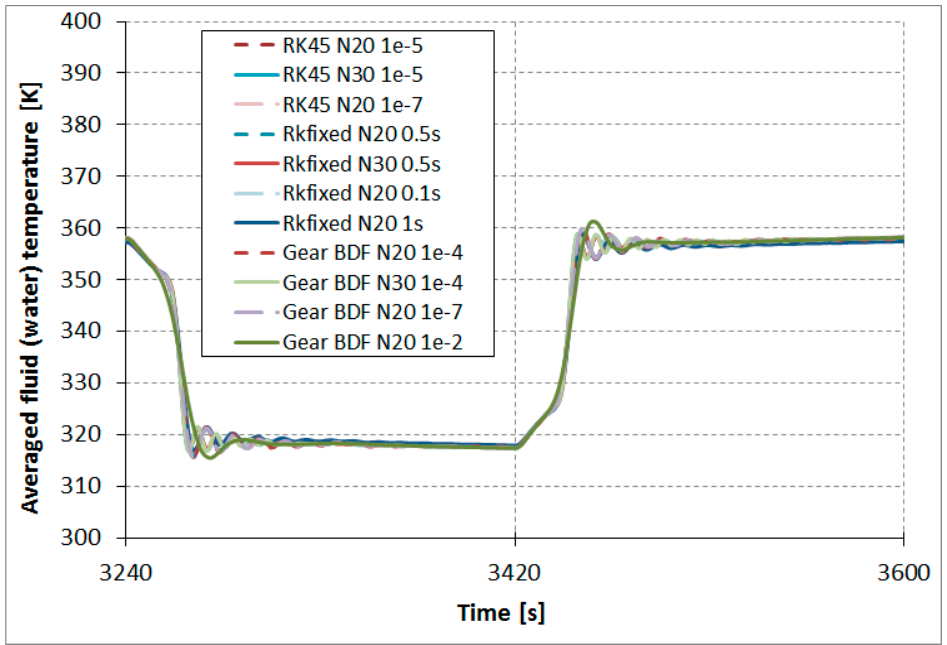
Figure 7. Results comparison of the RKfixed, RK45, and Gear BDF methods in different accuracies and discretizations, calculated averaged temperatures of the modeled fluid (water) T f